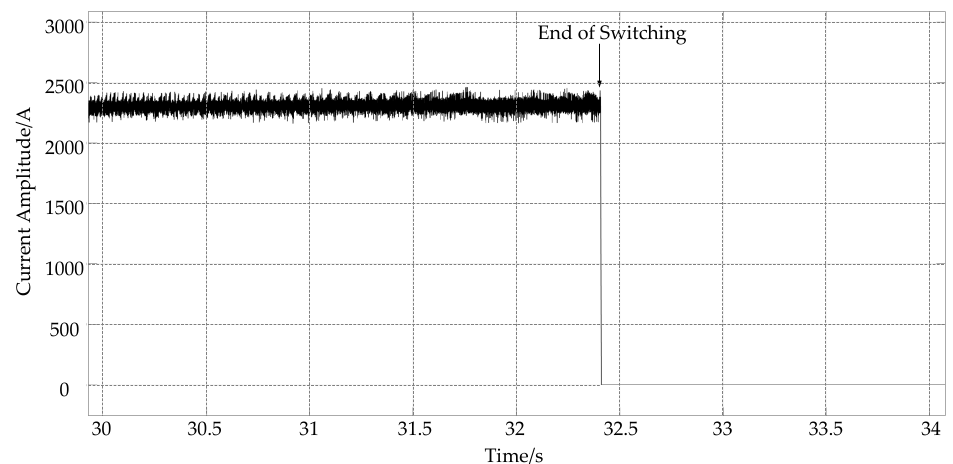
Figure 20. The q -axis current on the stator where the train is leaving.